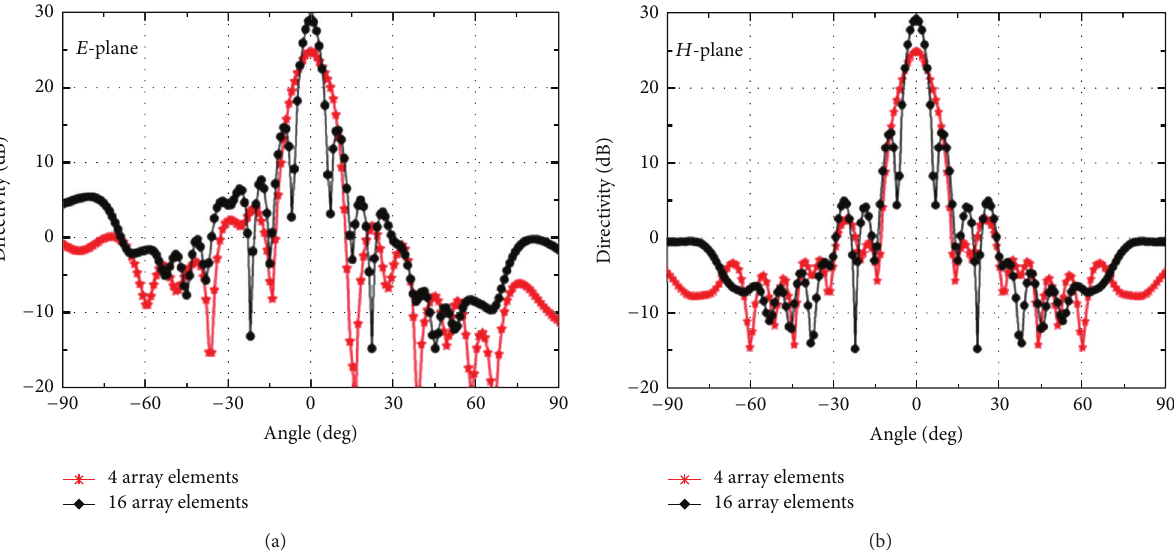
Figure 8: Antenna radiation patterns of the two arrays with MTMs-cover ( 𝐷 = 2.0𝜆 14.6 GHz ): (a) 𝐸 -plane; (b) 𝐻 -plane.